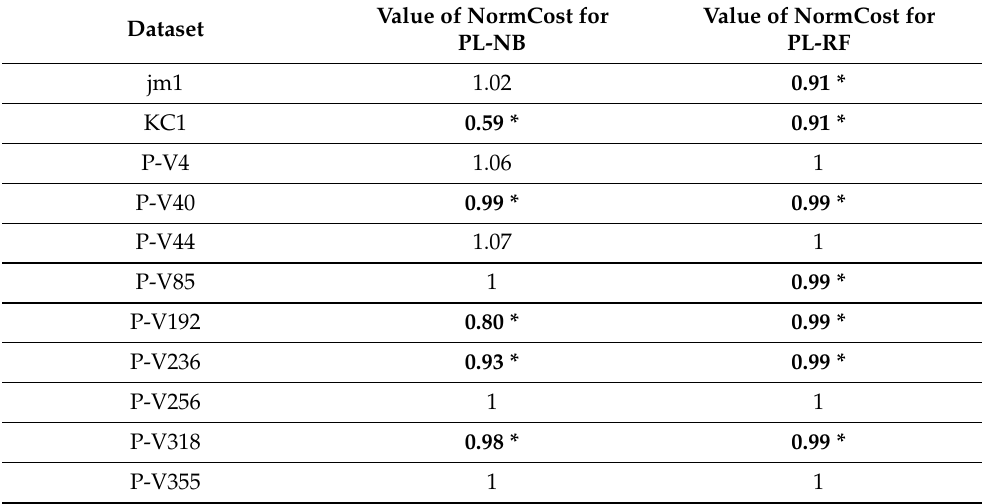
Table 7. Normalized